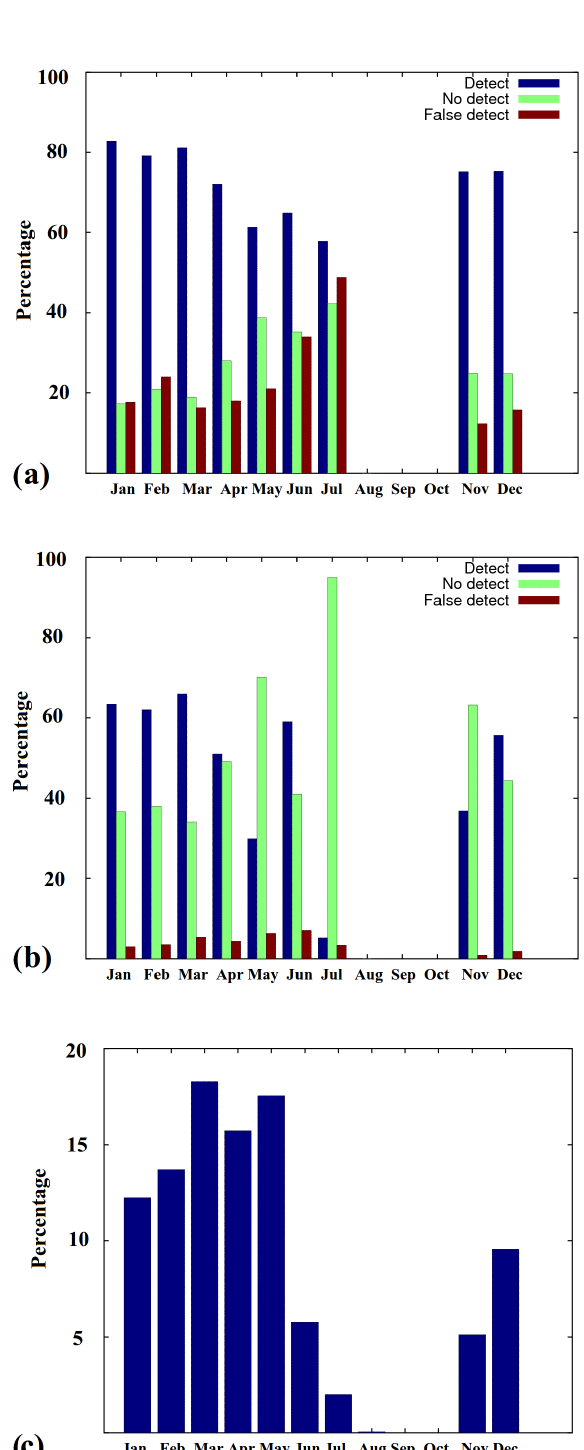
Figure 8. Monthly detection and false detection percentages for FMI-A (a) and FMI-B (b) compared to AARI ice chart LFI, and the relative number of (AARI) LFI points (c) in percents of the AARI LFI points of the whole year. This indicates the relative amount of LFI cover for each month compared to the LFI cover of the whole